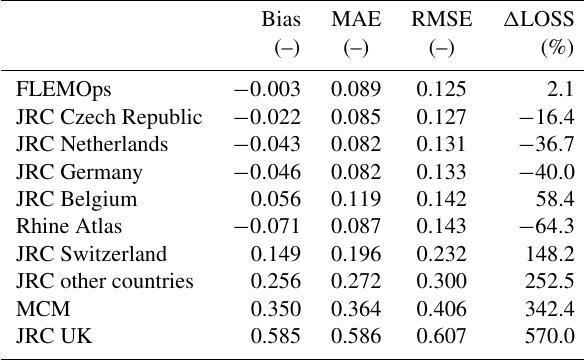
Table 5. Performance of different literature univariable models in estimating relative damages and overall monetary loss to buildings (see Eqs. 4, 5, 6 and 7; the observed overall monetary loss is equal to EUR15.2million). Models are ranked according to RMSE values, from the lowest to the largest. Corresponding results for uni- and multivariable models developed based on local data are reported in Table